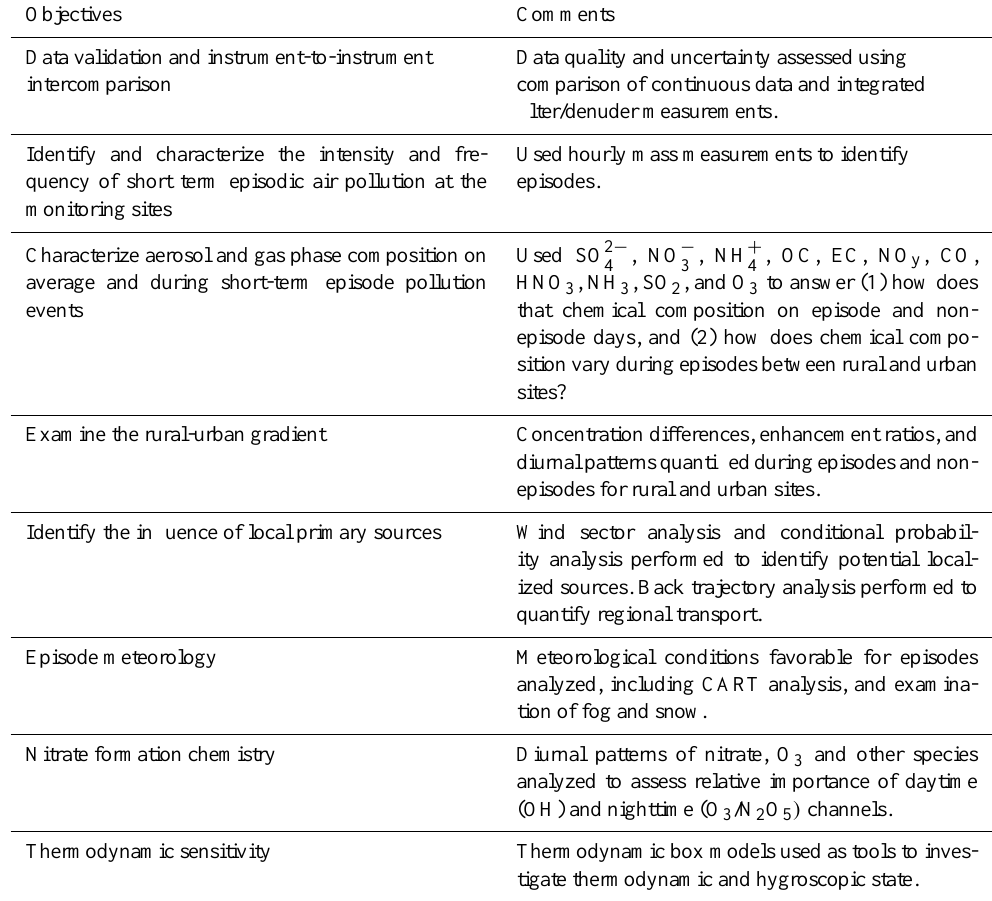
Table 1. Objectives of the LADCO WNS.